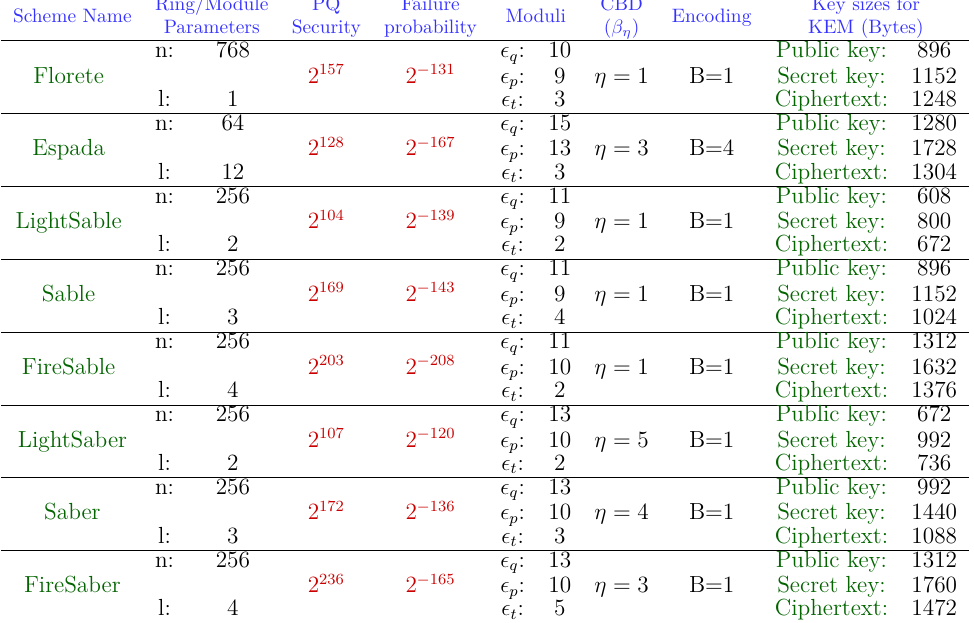
this increase is less than 25%. Table 2: Comparison of Scabbard suite with Saber Ring/Module Scheme Name